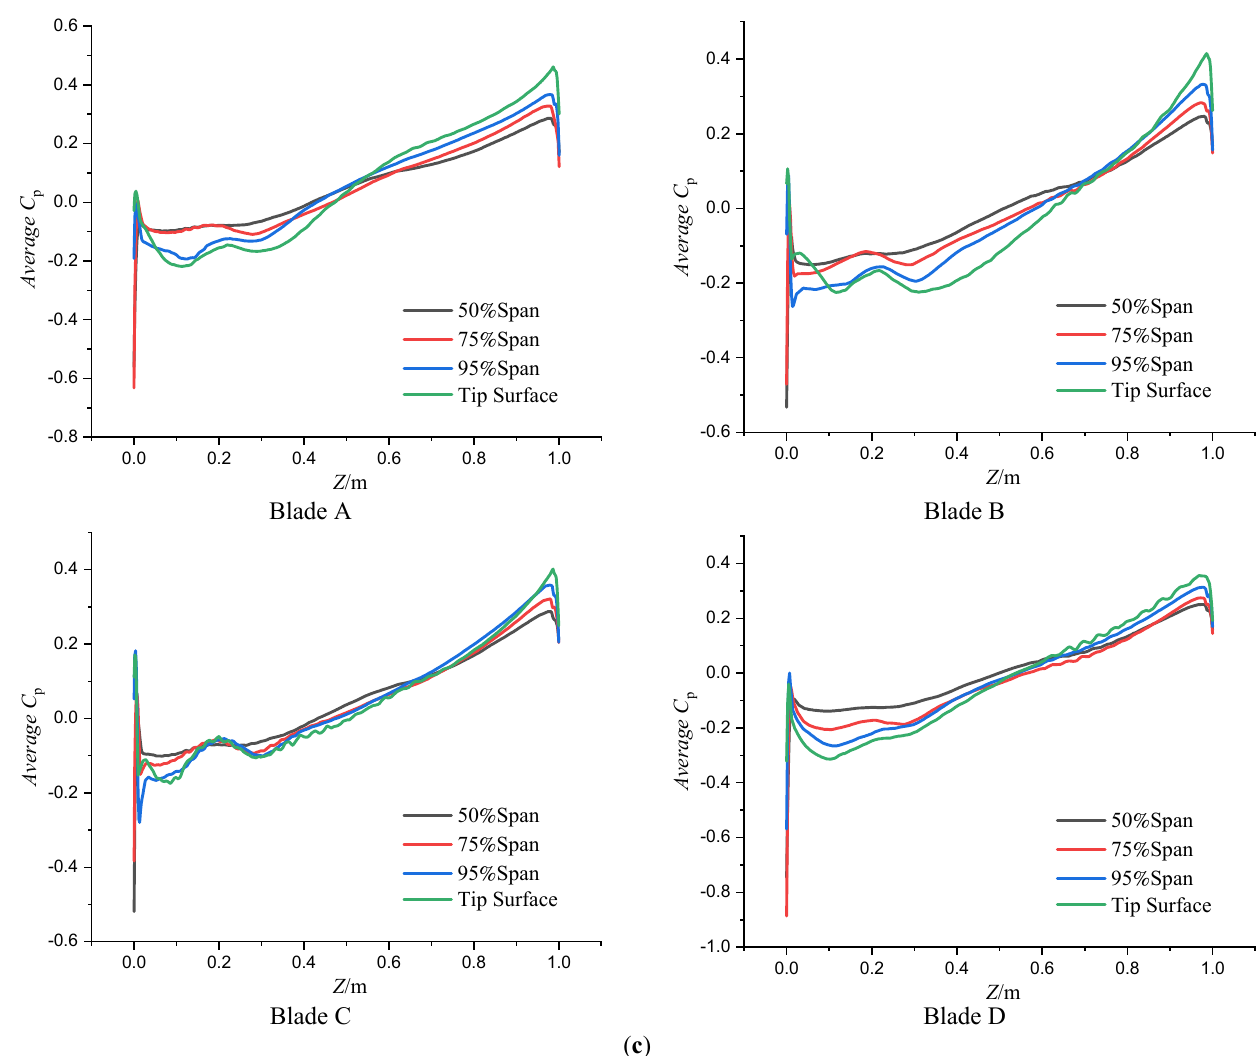
Figure 18. The mean distribution of pressure coefficient around blade surface with different eccentricities is 50% span, 75% span, 95% span, and tip surface. ( a ) e = 0 mm, ( b ) e = 3 × 10 − 1 mm, ( c ) e = 5 × 10 − 1 mm.